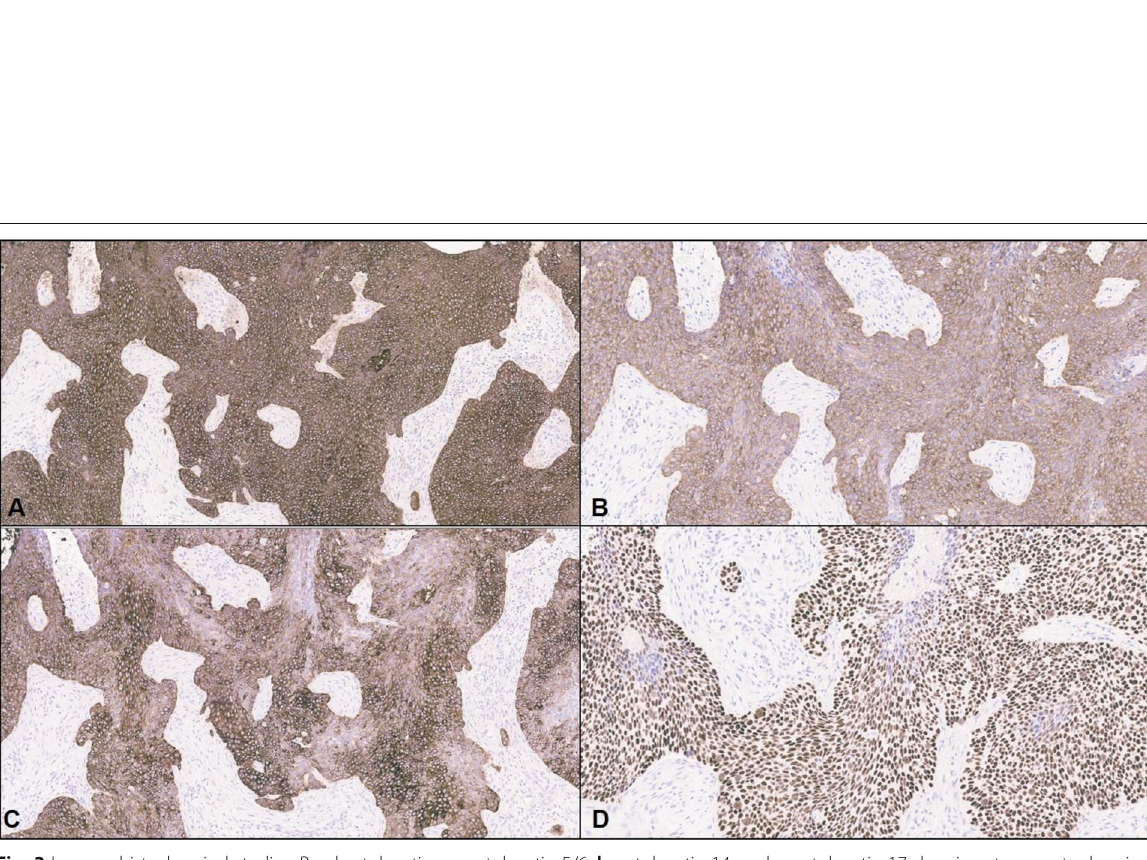
Fig. 3 Immunohistochemical studies. Basal cytokeratins: a . cytokeratin 5/6, b . cytokeratin 14, and c . cytokeratin 17 showing strong cytoplasmic and membranous staining. d . p63 showing strong nuclear staining, supporting myoepithelial